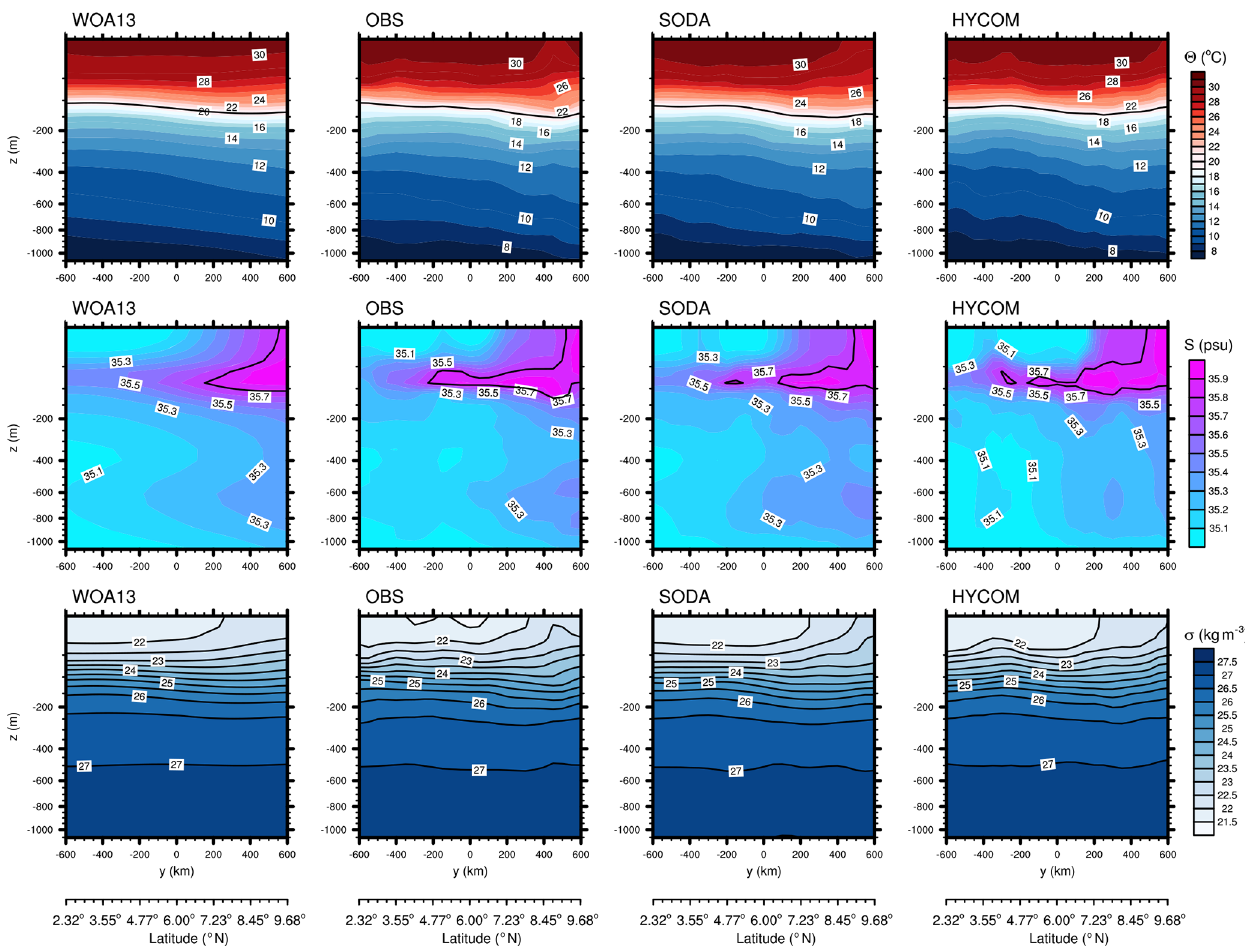
Figure 4. Sectional profiles of potential temperature (upper panels), salinity (middle panels), and potential density (lower panels). The data sources cover the World Ocean Atlas 2013 climatology (WOA13, version 2.0/A5B2, climatological monthly mean of May), the present observations, and two reanalysis datasets, SODA and HYCOM (monthly mean of May 2012). The isothermal lines of 20 ◦ C are highlighted in the potential temperatures, and the iso-salinity lines of 35.8psu are highlighted in the salinity